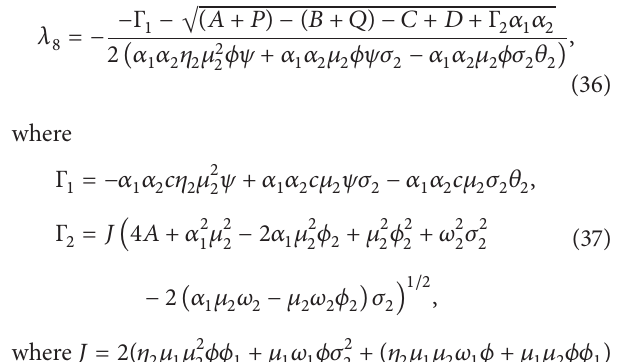
𝜇 + 𝑐𝜎 2 2 2 − ((𝜂 𝜇 + 𝜎 2 2 2